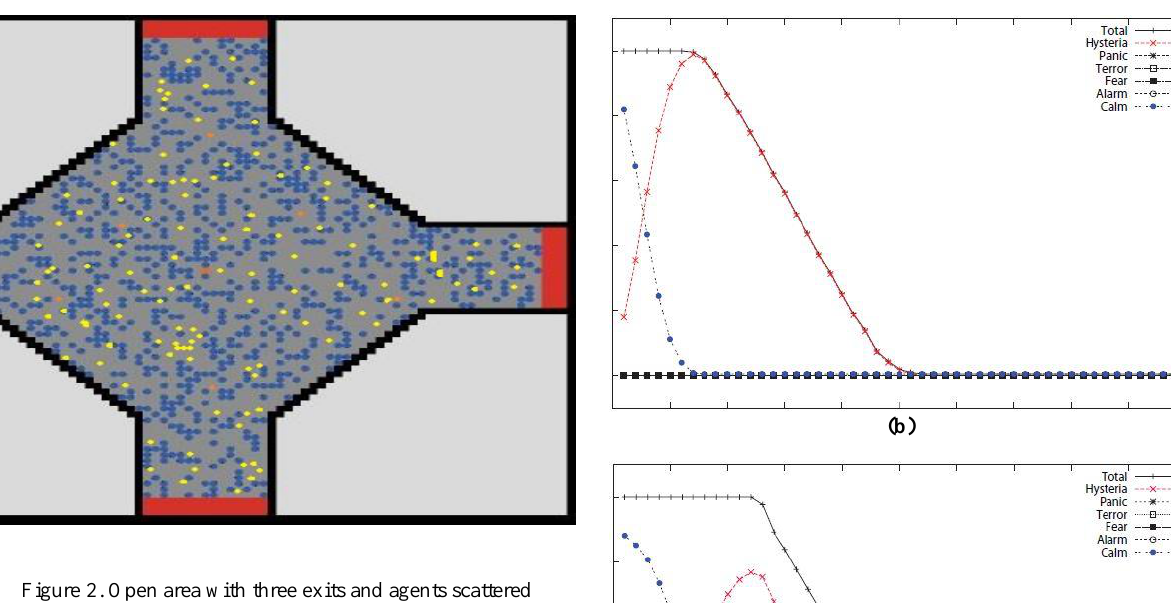
Figure 2. Open area with three exits and agents scattered